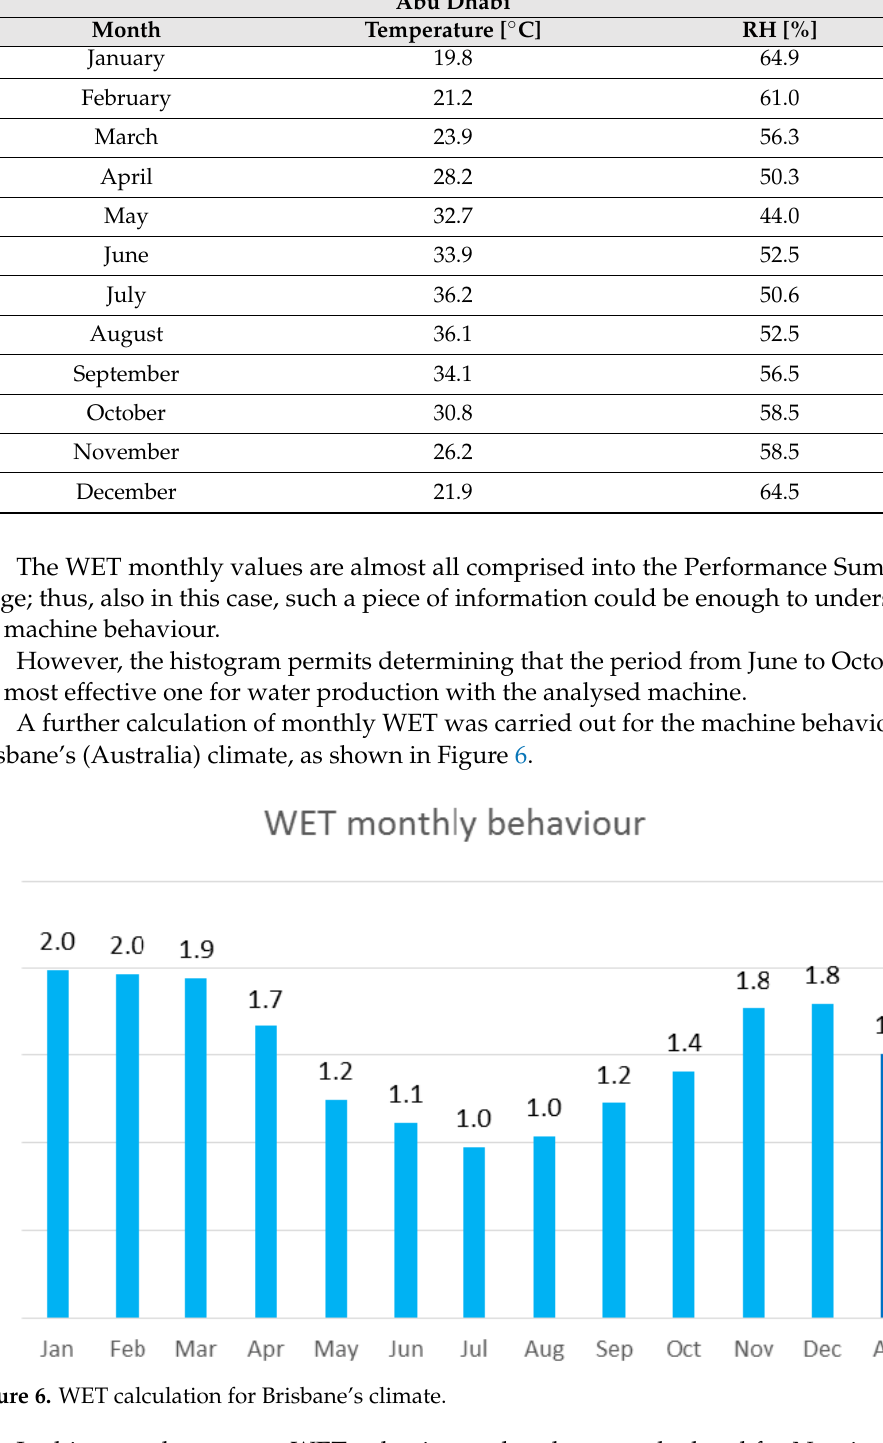
Table 11. Average weather data in